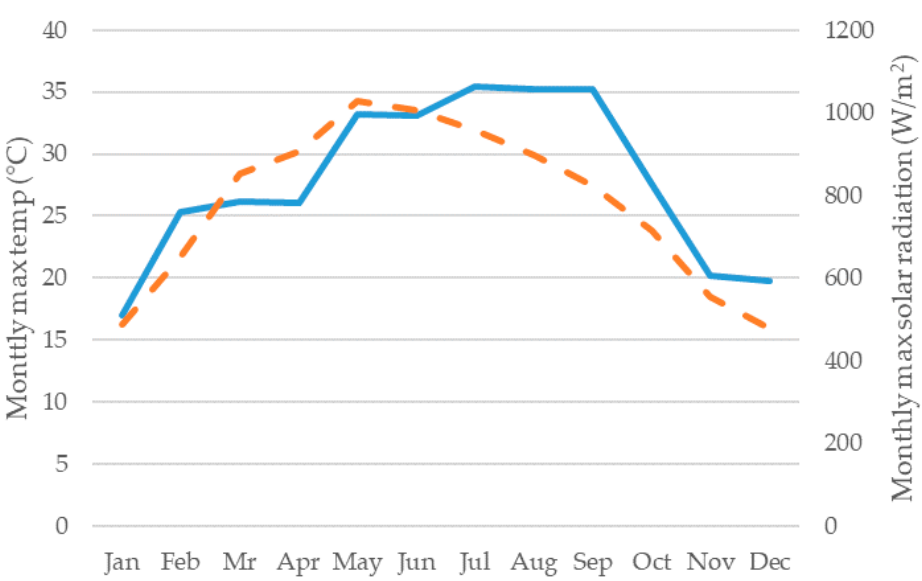
Figure 4. Monthly average maximum temperature (continuous line) and solar radiation (dotted line). Data from SNIRH-APA datasets [54].